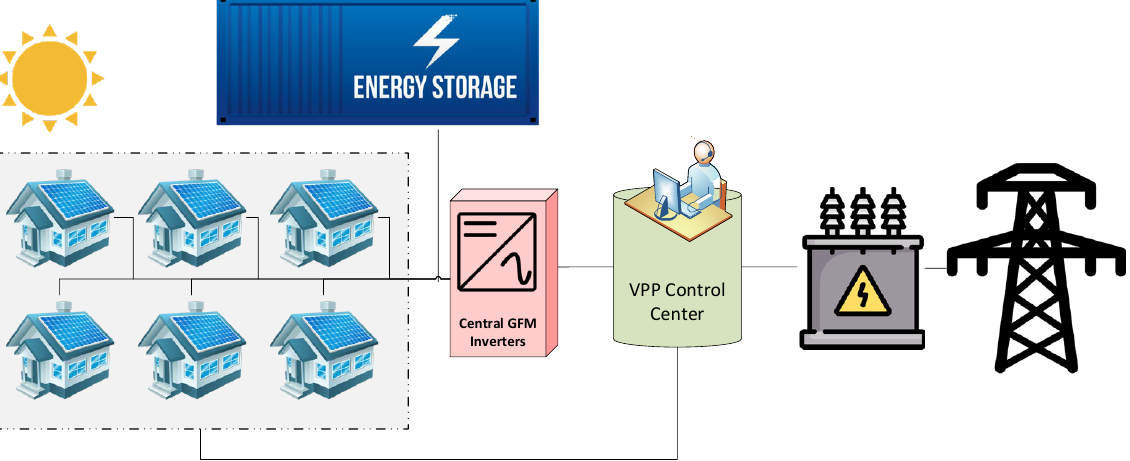
Figure 6. Schematic of a grid-forming VPP with energy storage.